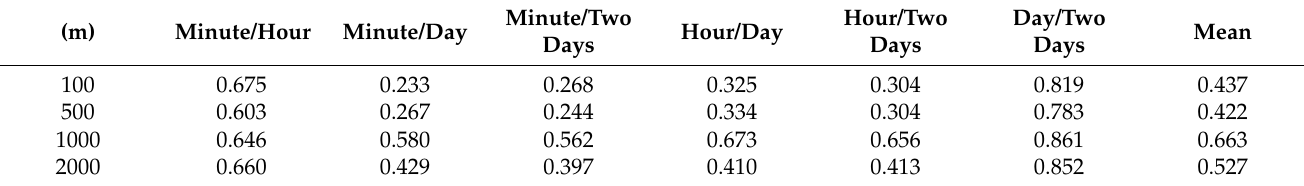
Table 8. Overall Kappa coefficients for results based on the same spatial scale and different temporal scales.